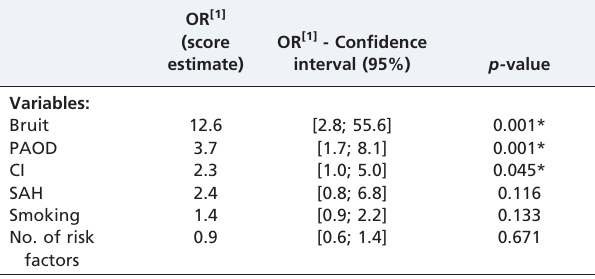
Table 5 - Logistic regression analysis for the most frequently occurring variables and positive ultrasound